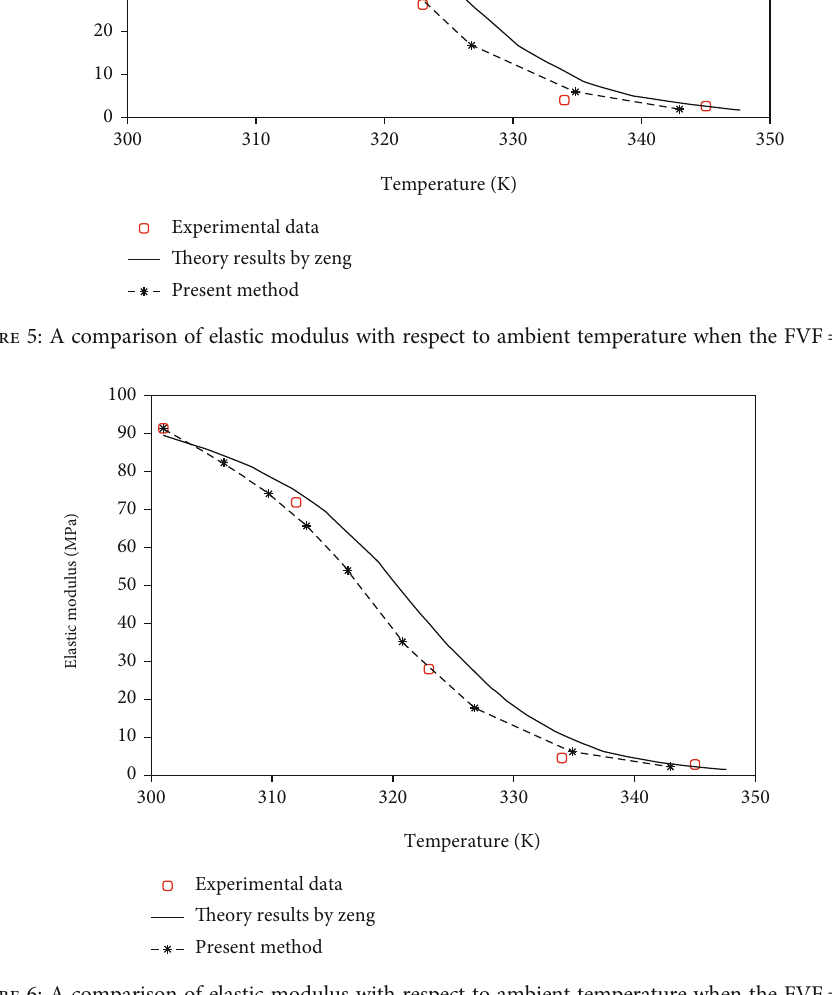
Figure 6: A comparison of elastic modulus with respect to ambient temperature when the FVF = 7 %